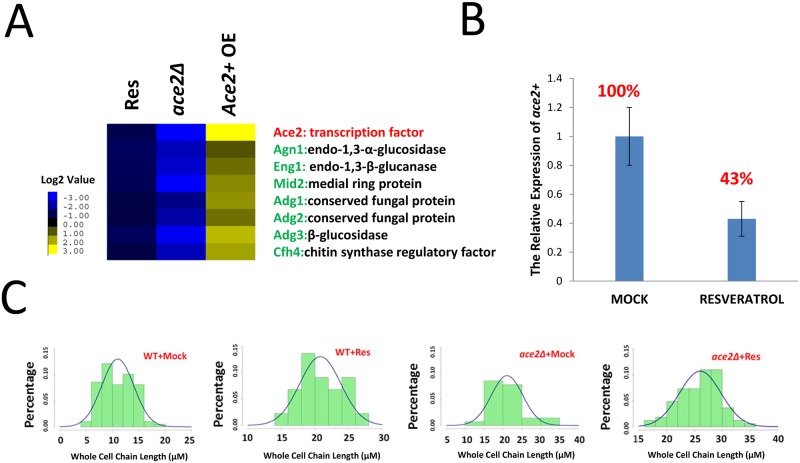
Resveratrol causes the similar cell phenotype and molecular signatures as knocking out ace2+ in vivo.(A) Clustering analysis of resveratrol-induced genes and previously reported Ace2 overexpression and knock-out datasets. Res denotes the resveratrol-treated sample, ace2Δ denoted the ace2+ gene knock-out sample, and ace2+ OE denoted the ace2+ gene overexpression sample. The ace2Δ and ace2+ OE datasets were downloaded from the website of Prof. Jürg Bähler from UCL. (B) The relative gene expression level of ace2+ after resveratrol treatment (120 μg/ml resveratrol treat 4 hrs). (C) The whole cell chain length measurement and statistical distribution of wild-type and ace2Δ yeasts with or without resveratrol treatment counted in more than 30 cells for every yeast sample.